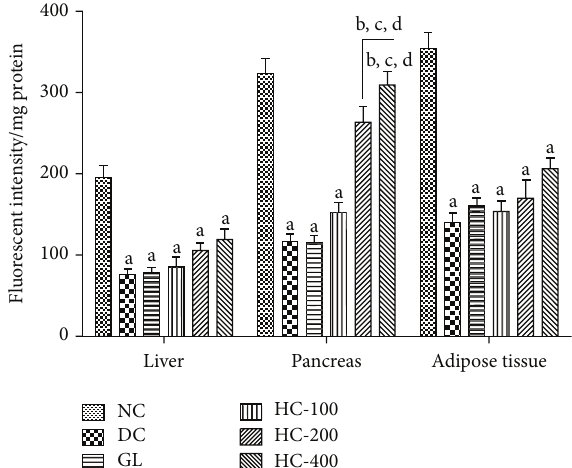
Figure 3: Effect of HC on MMP levels in liver, pancreas and adipose tissue in STZ-induced diabetic rats. Bars represent data as mean ± SEM, 𝑛 = 6 , a 𝑃 < 0.05 compared to normal control; b 𝑃 < 0.05 comparedtodiabeticcontrol; c 𝑃 < 0.05 comparedtoglibenclamide; d 𝑃 < 0.05 compared to HC 100 (one-way ANOVA followed by Tukey’s multiple comparison